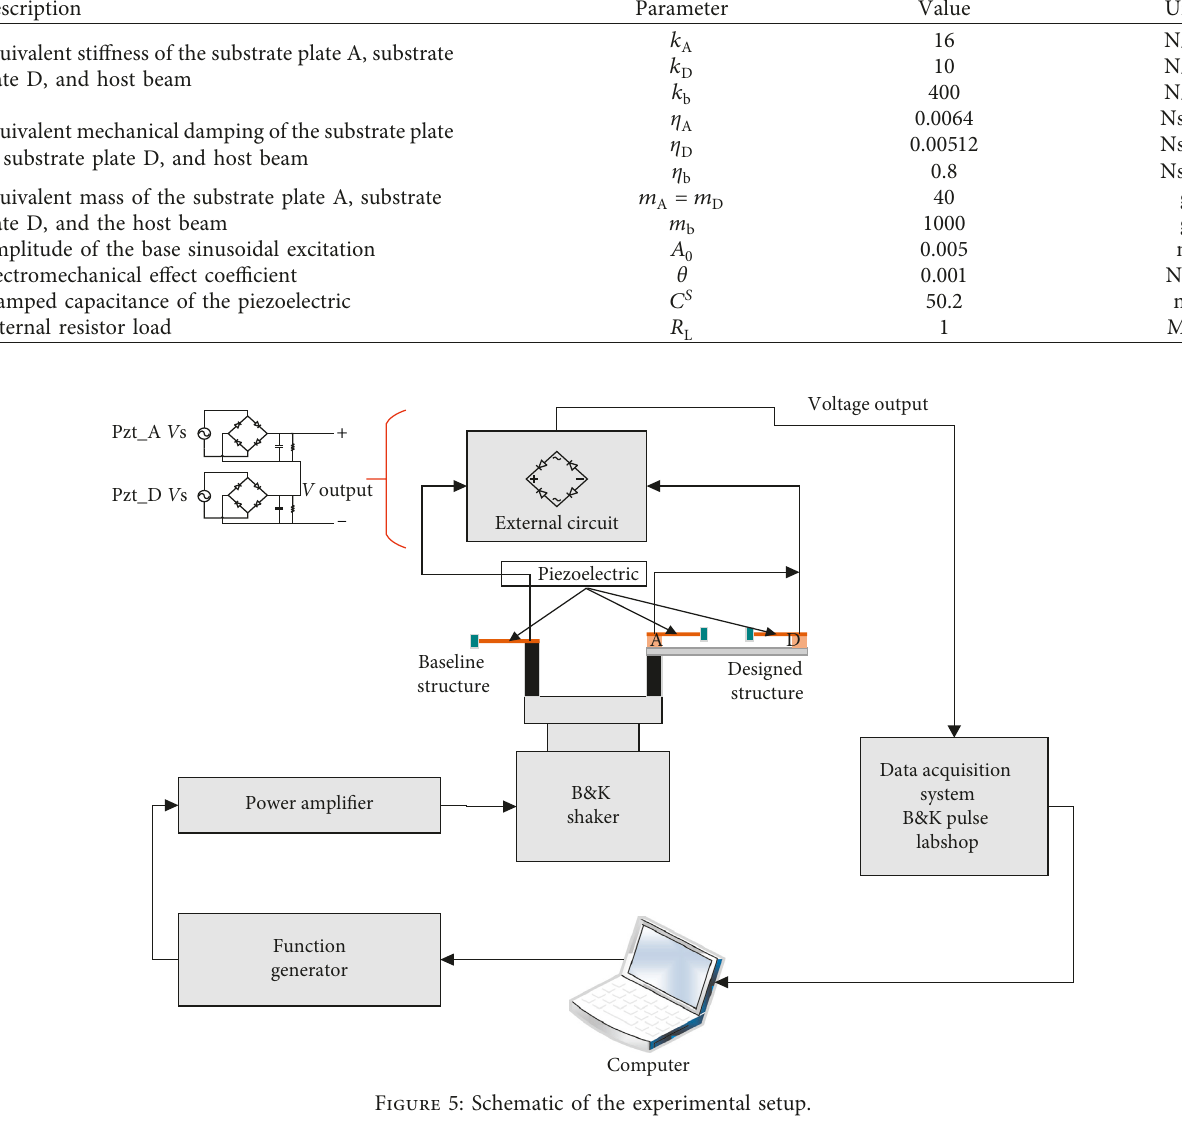
Table 2: Parameters of the equivalent model.